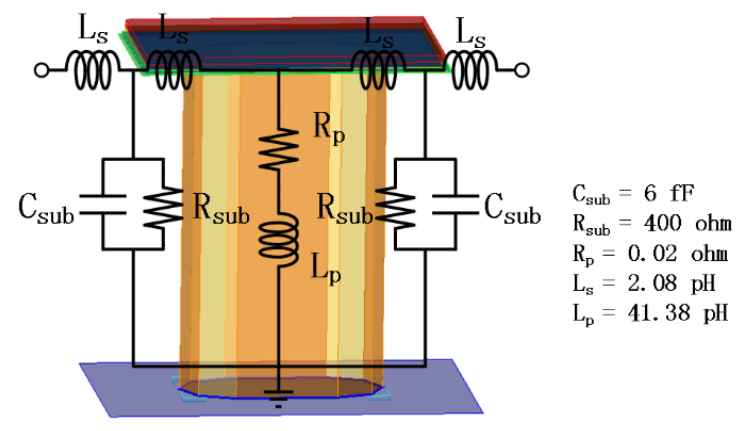
Figure 3. The equivalent circuit of the TWV. The shunt branches of the attenuators are grounded by TWVs, so the attenuators are not grounded ideally. Additional parasitic components would worsen the performance at high frequencies, especially in large attenuation units. To reduce the influence of the TWV on the attenuator, multiple TWVs are connected in parallel by the underlying metal layer. The number of the paralleled TWVs is optimized to satisfy the performance and chip size. It can be seen in Figure 4 that the attenuation curve of the 8-dB attenuator with two TWVs in parallel decreases first and then increases, being much flatter than that with just one TWV. At the same time, the phase difference is adjusted to a small value at high frequencies. Similarly, the 16-dB attenuator cells consist of two 8-dB cells, and all four TWVs are connected in